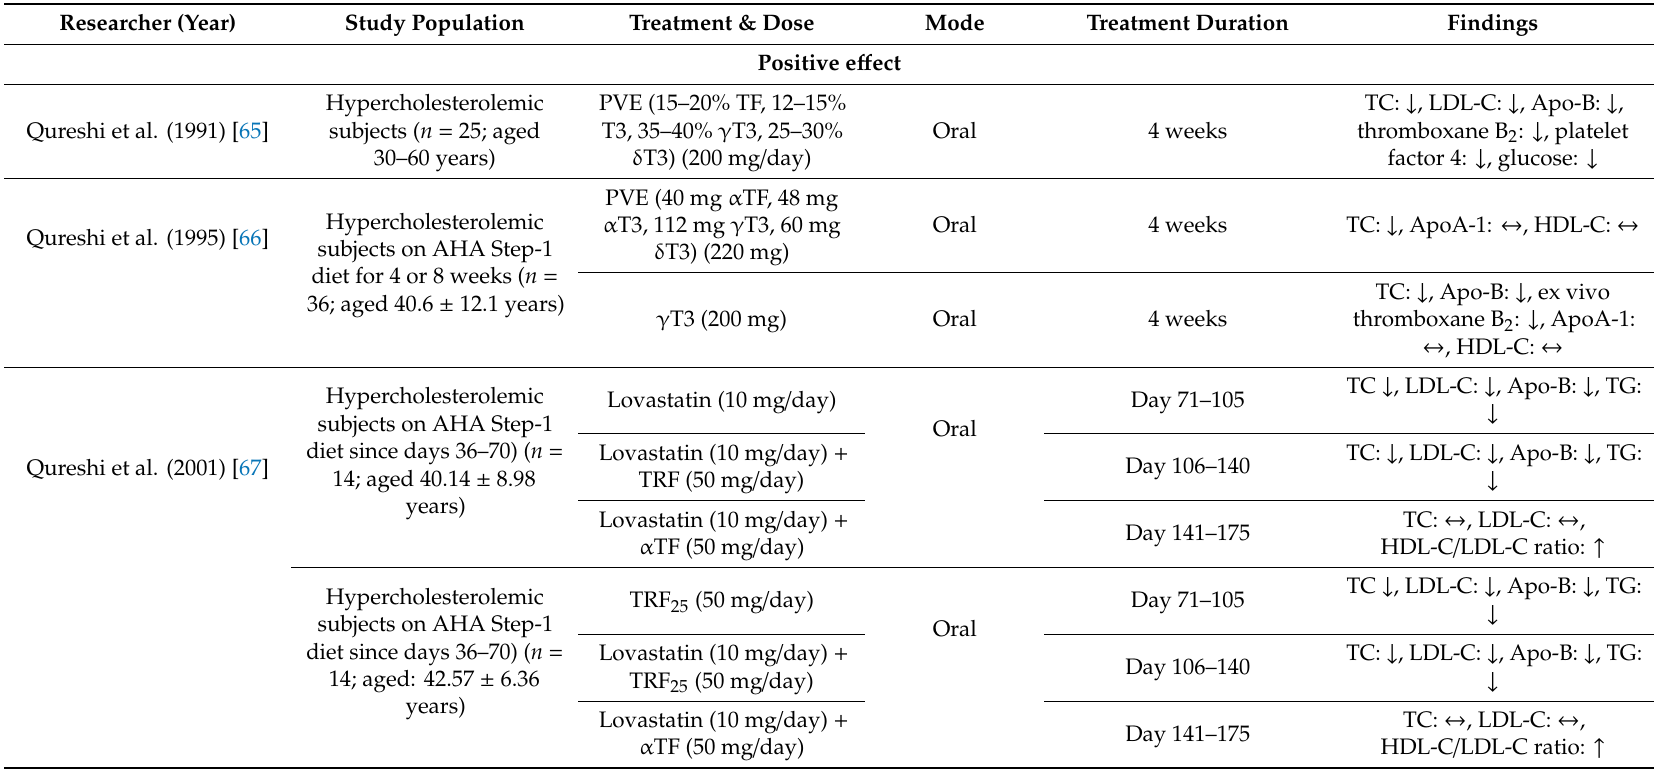
Table 3. E ff ects of T3 on lipid metabolism in